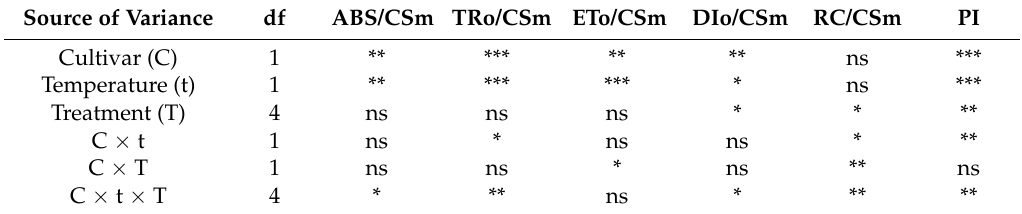
Table 5. Effects of temperature and pre-sowing seed treatment (two-way ANOVA) on the kinetics of chlorophyll a fluorescence in plants of two L. angustifolius cultivars grown at 7 ◦ C and 13 ◦ C for the first four weeks from seeds germinated in water, three-hour hydroprimed or treated with 10 − 6 M, 10 − 5 M, 10 − 4 M